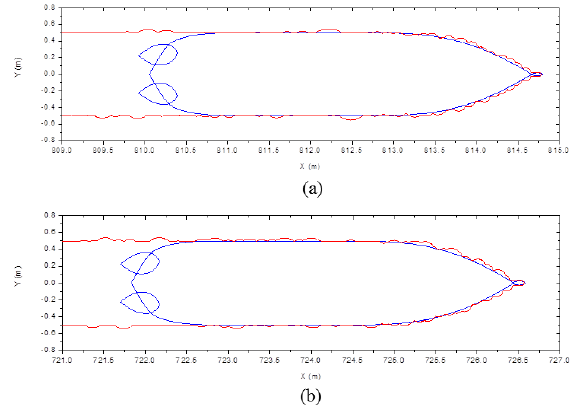
Figure 15: Comparison between the simulated ice force (in surge direction) time-series, running ahead in 12 . 43 mm (0 . 30 m full-scale) level ice with deterministic and random crack size.